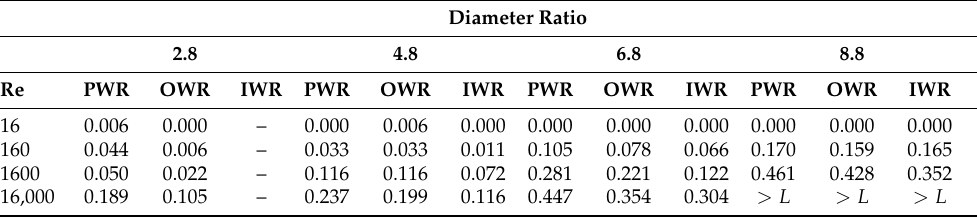
Table 7. Calculated thermal entry